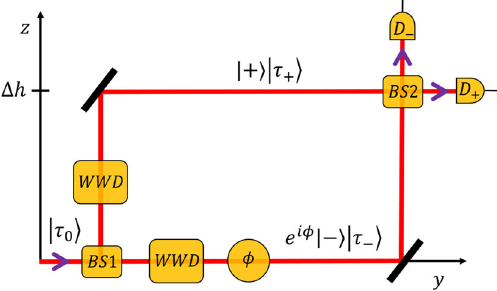
Fig. 2 ThisfigureillustratestheMach-ZehnderinterferometerinFig.1 with the addition of an extra degree of freedom that is able to encode the which-way information. Apart from the two beam splitters BS1, BS2 and the two detectors D ± , we now have a which-way detector indicated by WWD. The main difference with respect to the simpler configuration of Fig.1 lies in the possibility that the interfering system andWWDcanbecomeentangled,therebyallowingtoobtainthewhich- way information from WWD. At the same time, the interferometric visibility V isreduced,whichtellsusthatthecomplementarityprinciple still holds even for a composite